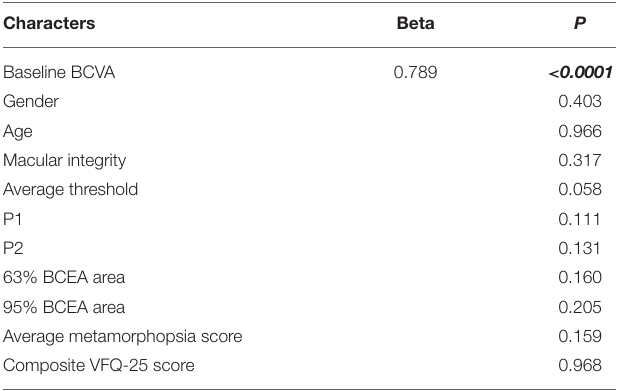
TABLE 6 | Multiple linear regression model to evaluate the factors associated with the final BCVA.